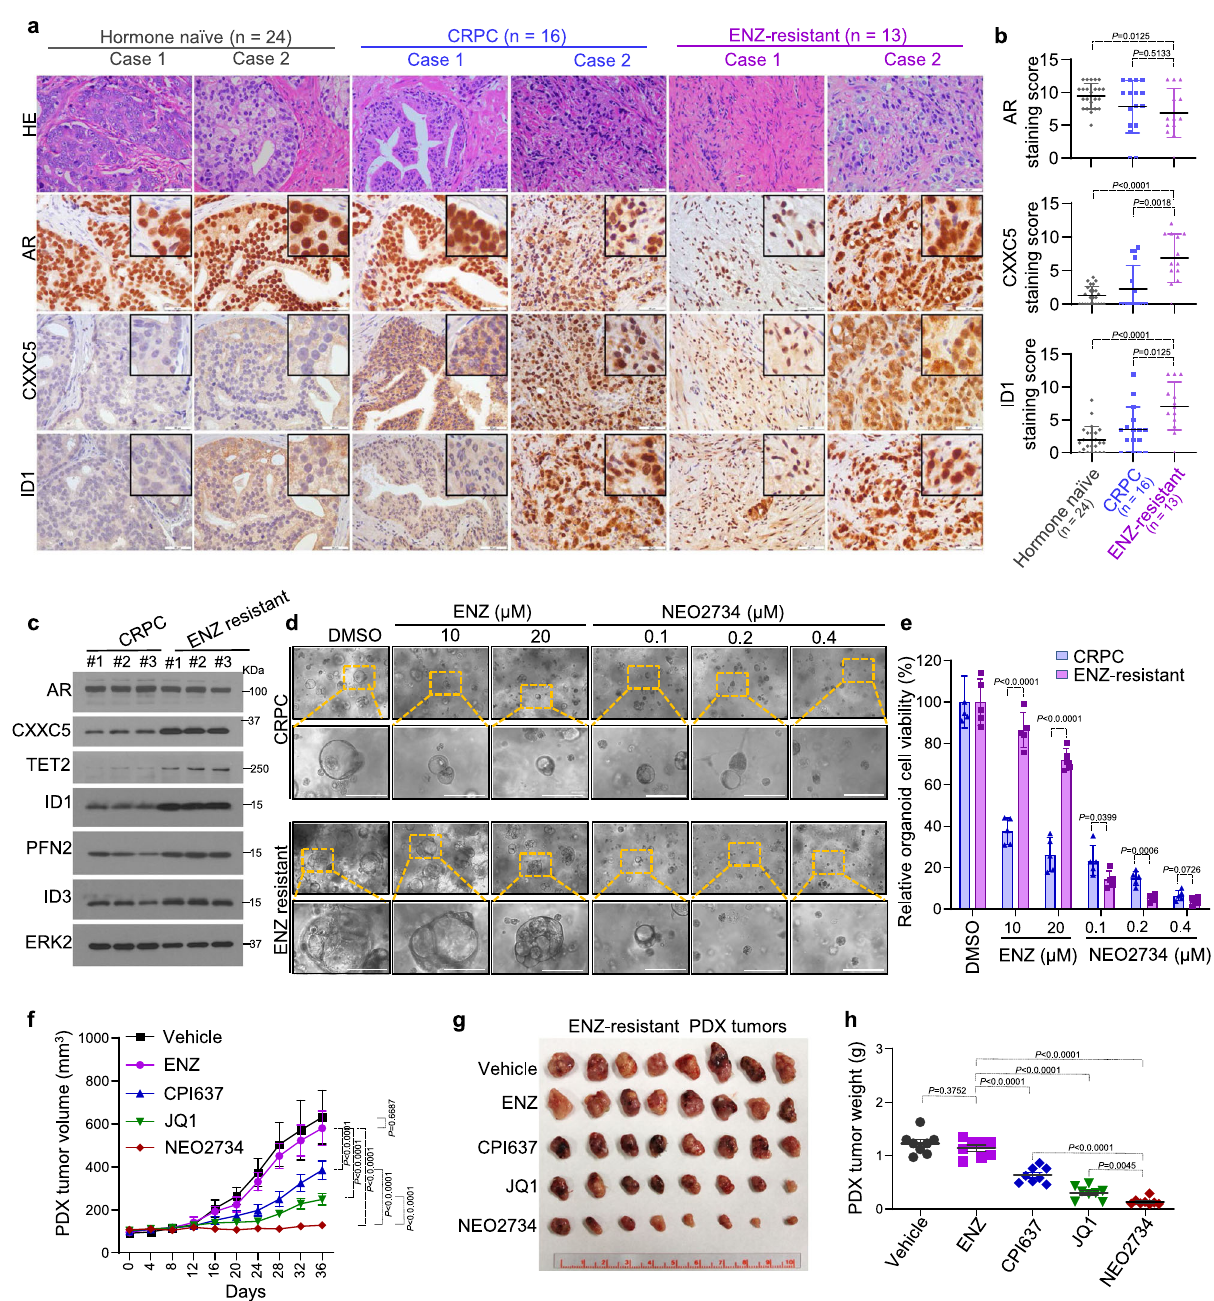
Fig. 6 Noncanonical AR target expression in ENZ-R CRPC patient samples and therapeutic targeting of noncanonical AR activity in organoids and PDXs. Representative images for HE staining and IHC of AR, CXXC5, and ID1 in hormone naive ( n = 24), CRPC ( n = 16), and ENZ-resistant ( n = 13) PCa patient specimens (scale bar, 50 μ m) ( a ) and quanti fi cation of IHC ( b ). Data are represented as means± s.d. Statistical signi fi cance was determined by unpaired two-tailed Student ’ s t tests. c Western blot analysis of AR, CXXC5, TET2, ID1, PFN2, and ID3 in CRPC and ENZ-resistant PCa PDXs (three tumors for each PDX). d , e Organoids derived from CRPC and ENZ-resistant PDX tumors were treated with the indicated inhibitors for 10 days. Representative images (scale bar, 100 μ m) were taken ( d ) and cell viability was determined ( e ). Data shown as ±s.d., ( n = 5 replicates/group). Statistical signi fi cance was determined by unpaired two-tailed Student ’ s t tests. f – h Effect of the indicated inhibitors on ENZ-resistant PDX tumor volume and weight; Data shown as ±s.d., ( n = 8 replicates/group). Statistical signi fi cance was determined by two-way ANOVA for tumor volume and by unpaired two-tailed Student ’ s t tests for tumor